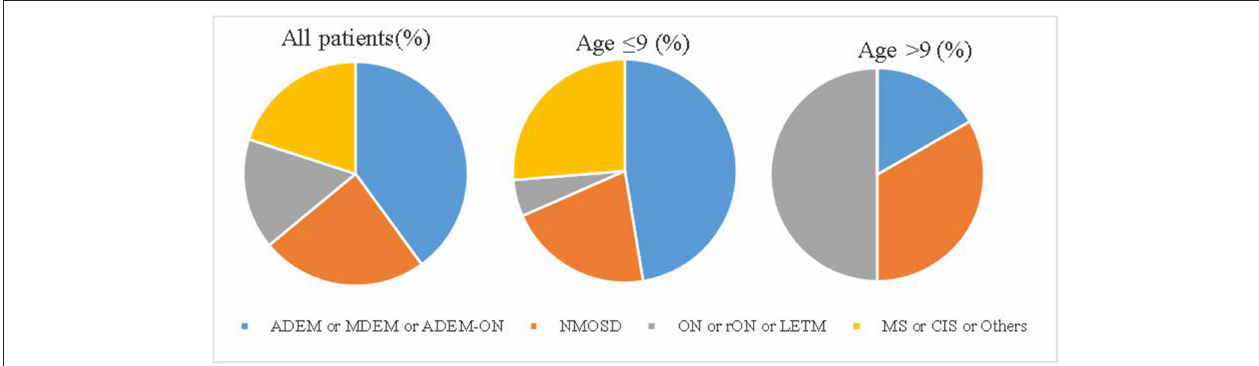
FIGURE 1 | The disease spectrum of each group. ADEM, acute disseminated encephalomyelitis; CIS, clinically isolated syndrome; LETM, longitudinally extensive transverse myelitis; MS, multiple sclerosis; MDEM, multiple disseminated encephalomyelitis; NMOSDs, neuromyelitis optica spectrum disorders; ON, optic neuritis; rON, recurrent optic